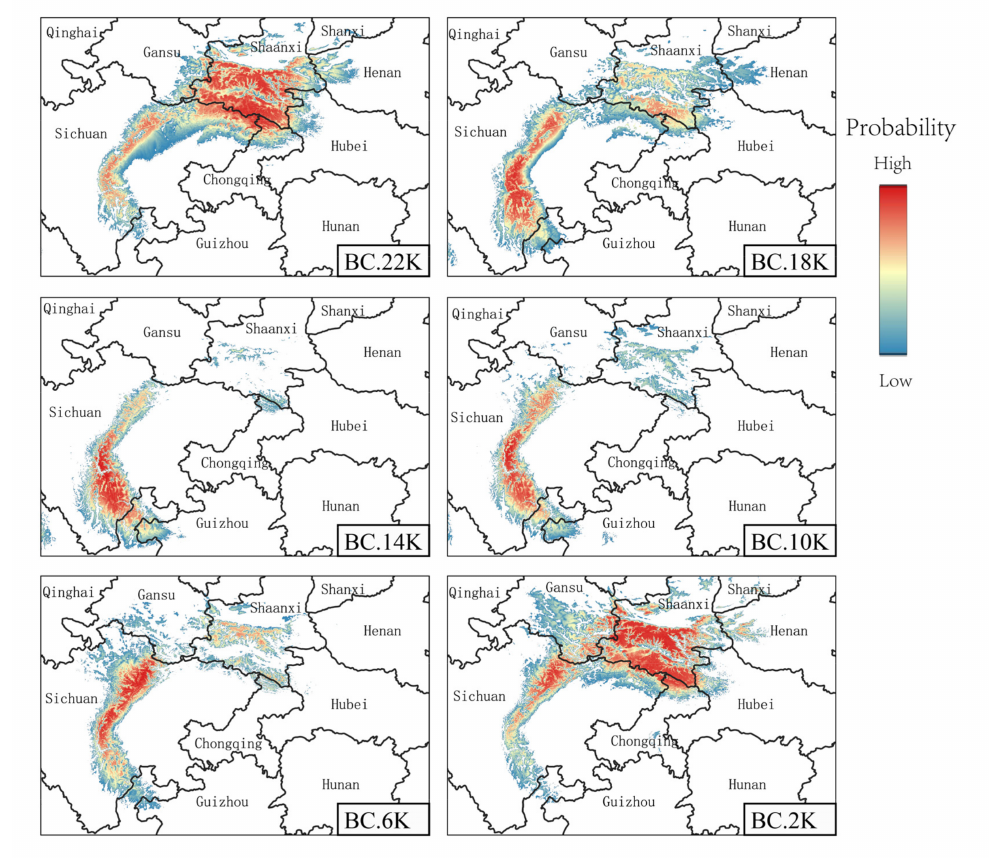
Figure 4. Paleo potential distribution of H. thibetanus .